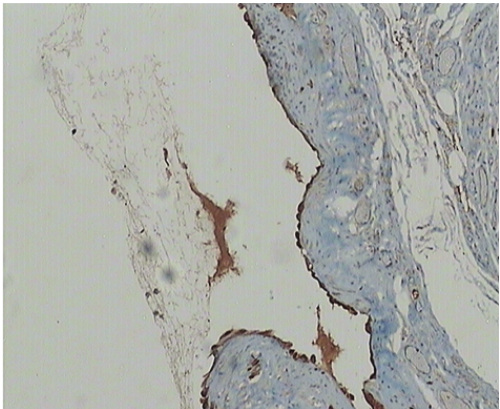
Figure 3: Calretinin stain (IHC × 100).